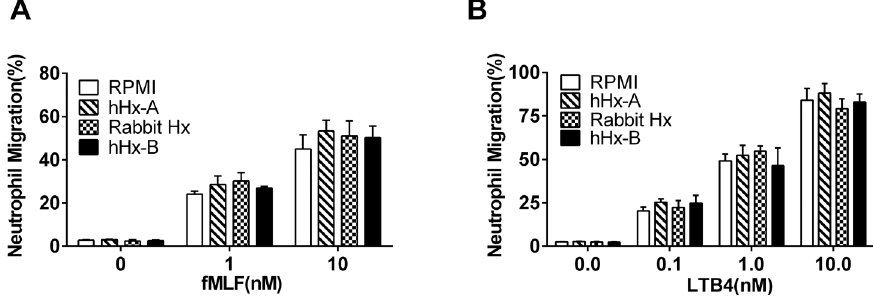
Figure 2. Purified Hxs do not inhibit the chemotaxis of neutrophils induced by fMLF and LTB4. Human neutrophils were preincubated with different purified Hxs (hHx-A, rabbit Hx and hHx-B) or control (RPMI 1640 containing 2% FBS) for 1 h. Then 1–2.5 × 10 5 cells/30 μ l cells were applied to the top of the transwell with the lower microplate filled with fMLF (1 nmol/L and 10 nmol/L) (A) or LTB4 (0.1 nmol/L, 1 nmol/L and 10 nmol/L) (B) and incu- bated for 1 h. Neutrophils migrated to the bottom microplate wells were stained with 0.4% trypan blue and live cells were counted. The percentage of cells migrated over the total cells uploaded to the top of the transwell was calculated. The results represent the mean ± SE and are representative of three independent experiments.